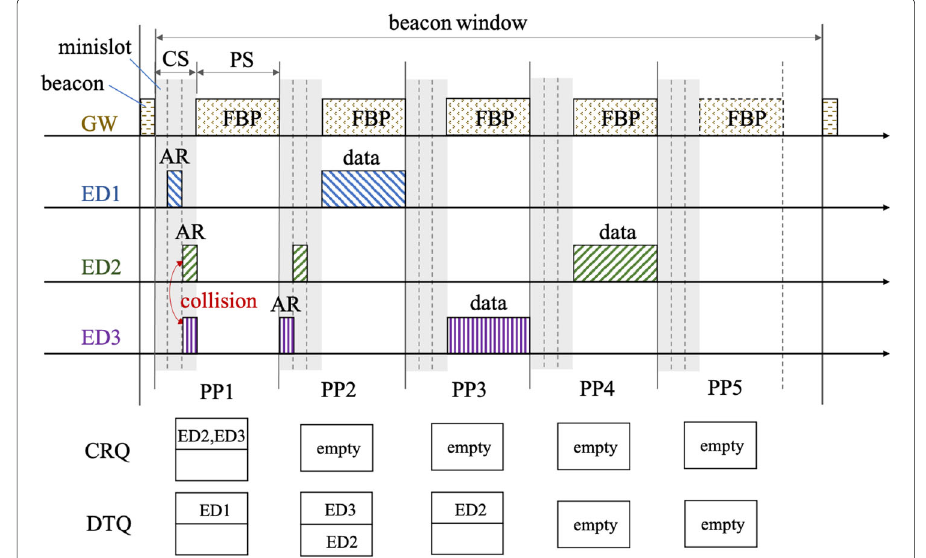
Fig. 1 An example to illustrate the access procedure of